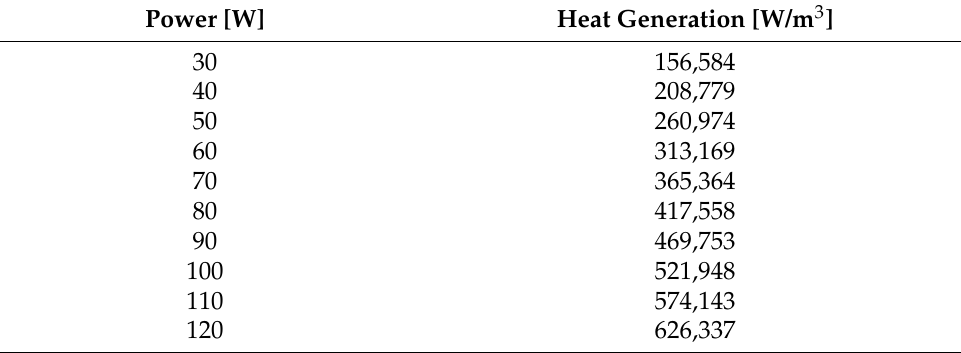
Table 4. Assumed value of the heat generation in the electronic component.